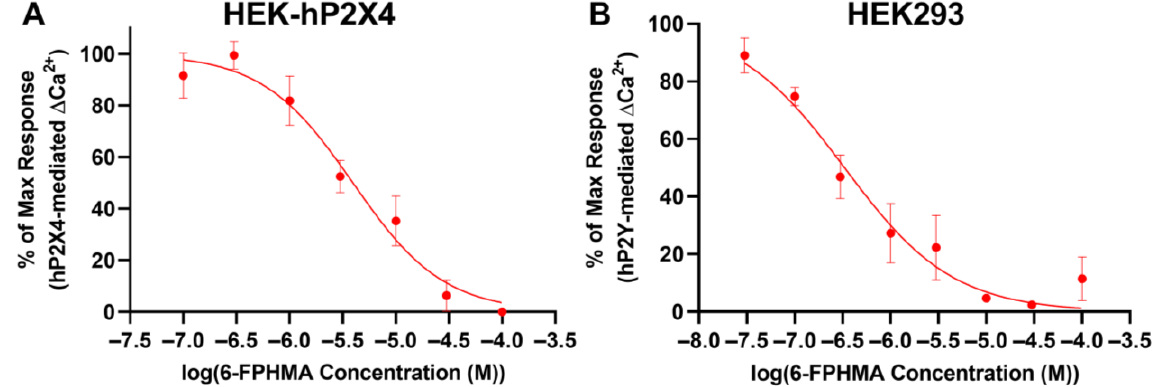
(Figure S7E, Supplementary Material). 6-FPHMA inhibited endogenous hP2Y-mediated Ca 2+ responses in a concentration-dependent manner with 97% inhibition at 30 µ M and an IC 50 of 0.33 ± 0.13 µ M (Figure 5B).